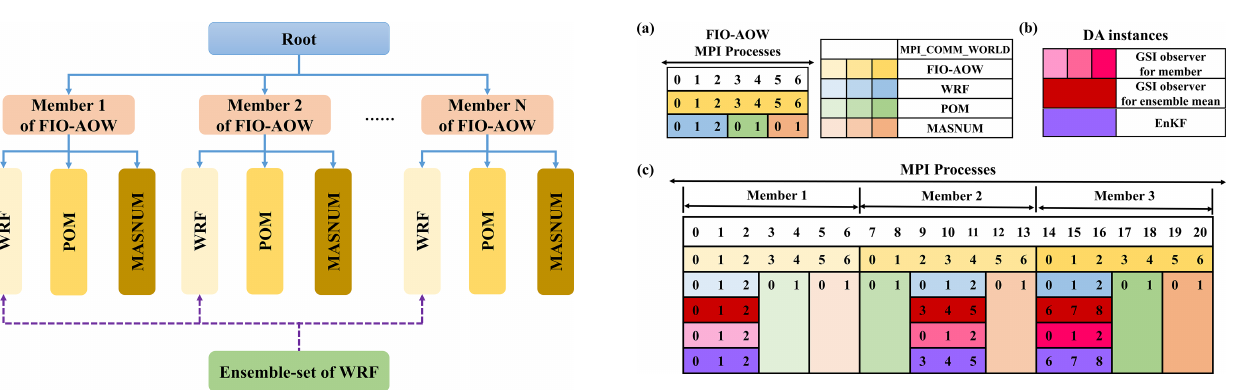
Figure 11. Two-hierarchical-level organizational architecture for N ensemble members of FIO-AOW consisting of WRF, POM and MASNUM. All ensemble members of FIO-AOW are organized as the first level with all component models in each ensemble member at the second level. An ensemble-set that covers all ensemble mem- bers of the component model WRF is generated by the ensemble component manager.